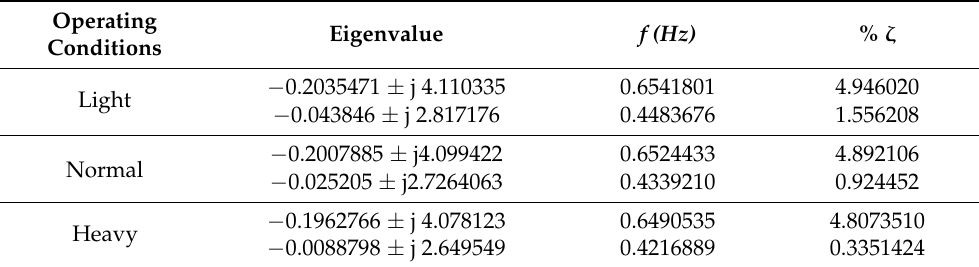
Table 11. Open-loop inter-area modes of IEEE 50-Machine Power